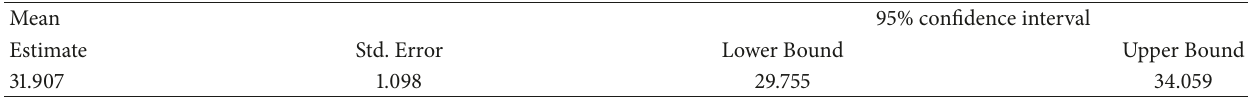
Table 3: The mean duration of death for MDR TB patients.